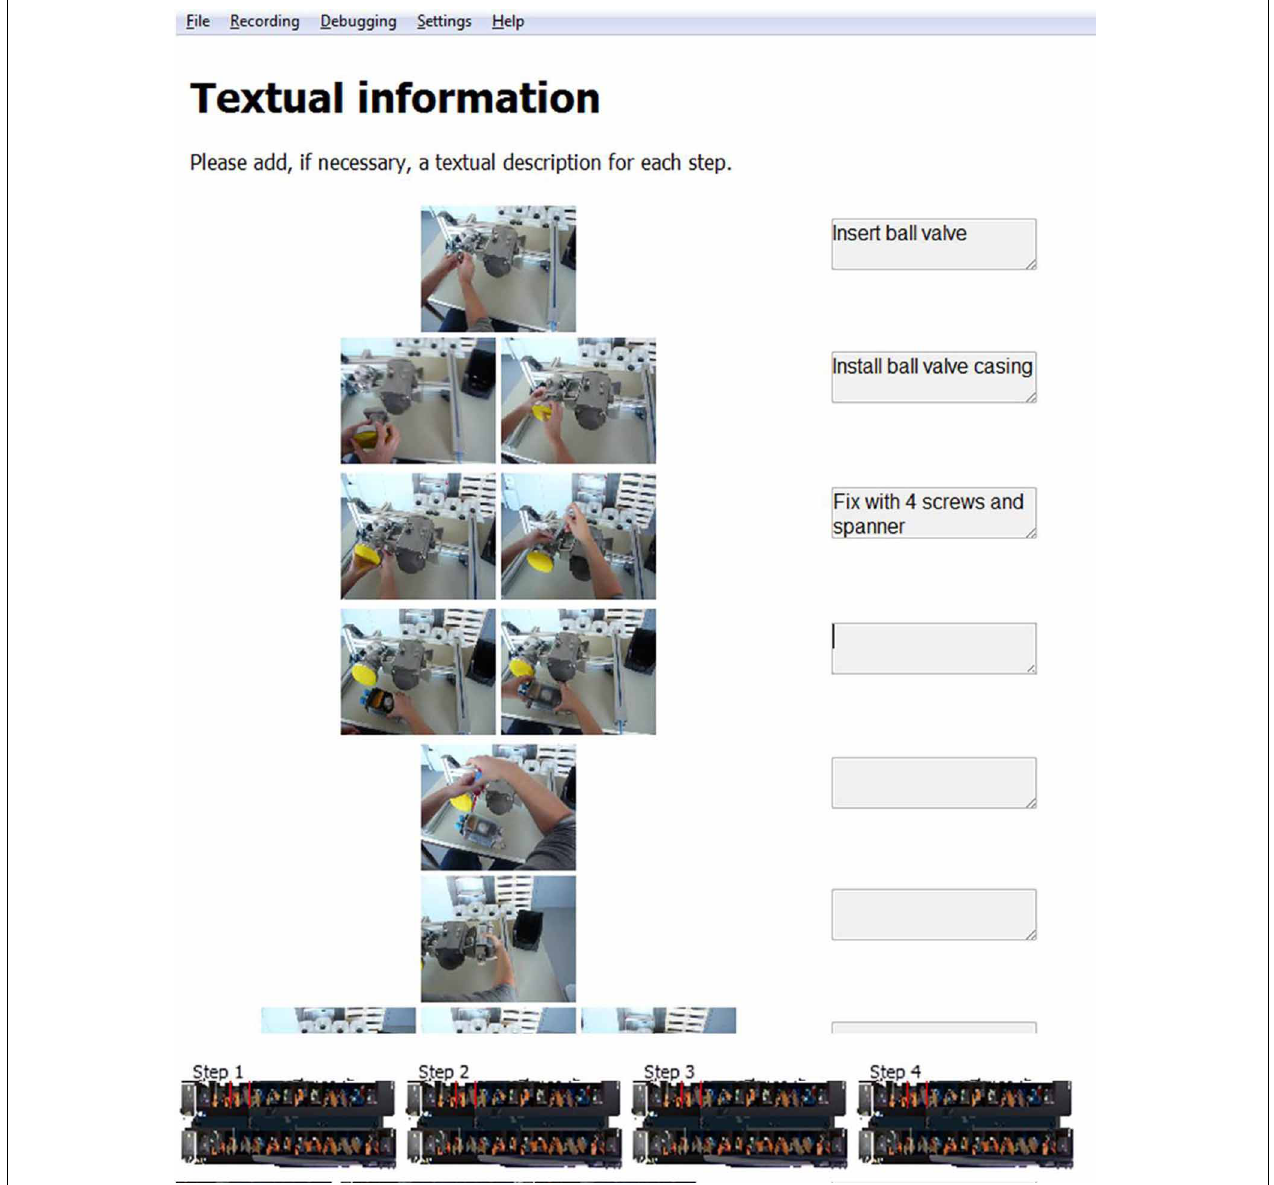
FIGURE 3 | Screenshot for step 3 within the IBES tool where users may edit textual description for each instructional